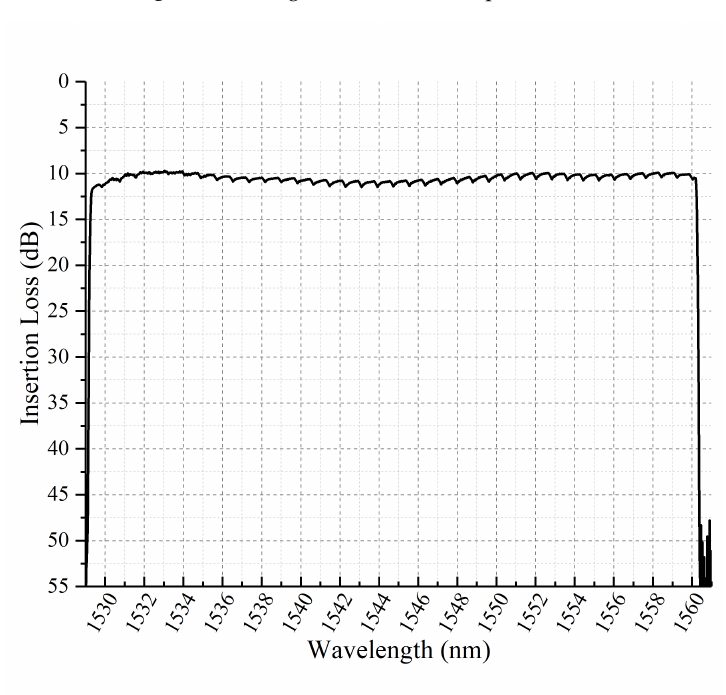
Figure 7. Total insertion loss as a function of C-band wavelength in filter